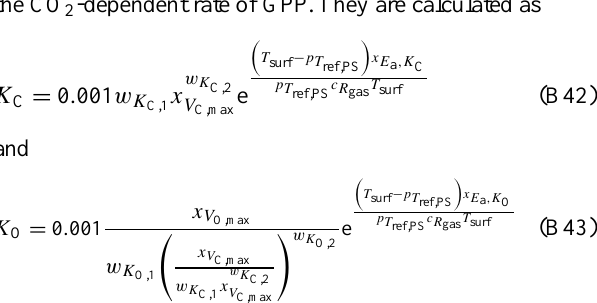
reduces the electron flow to the area covered by a lichen or bryophyte and s B is the biomass of the